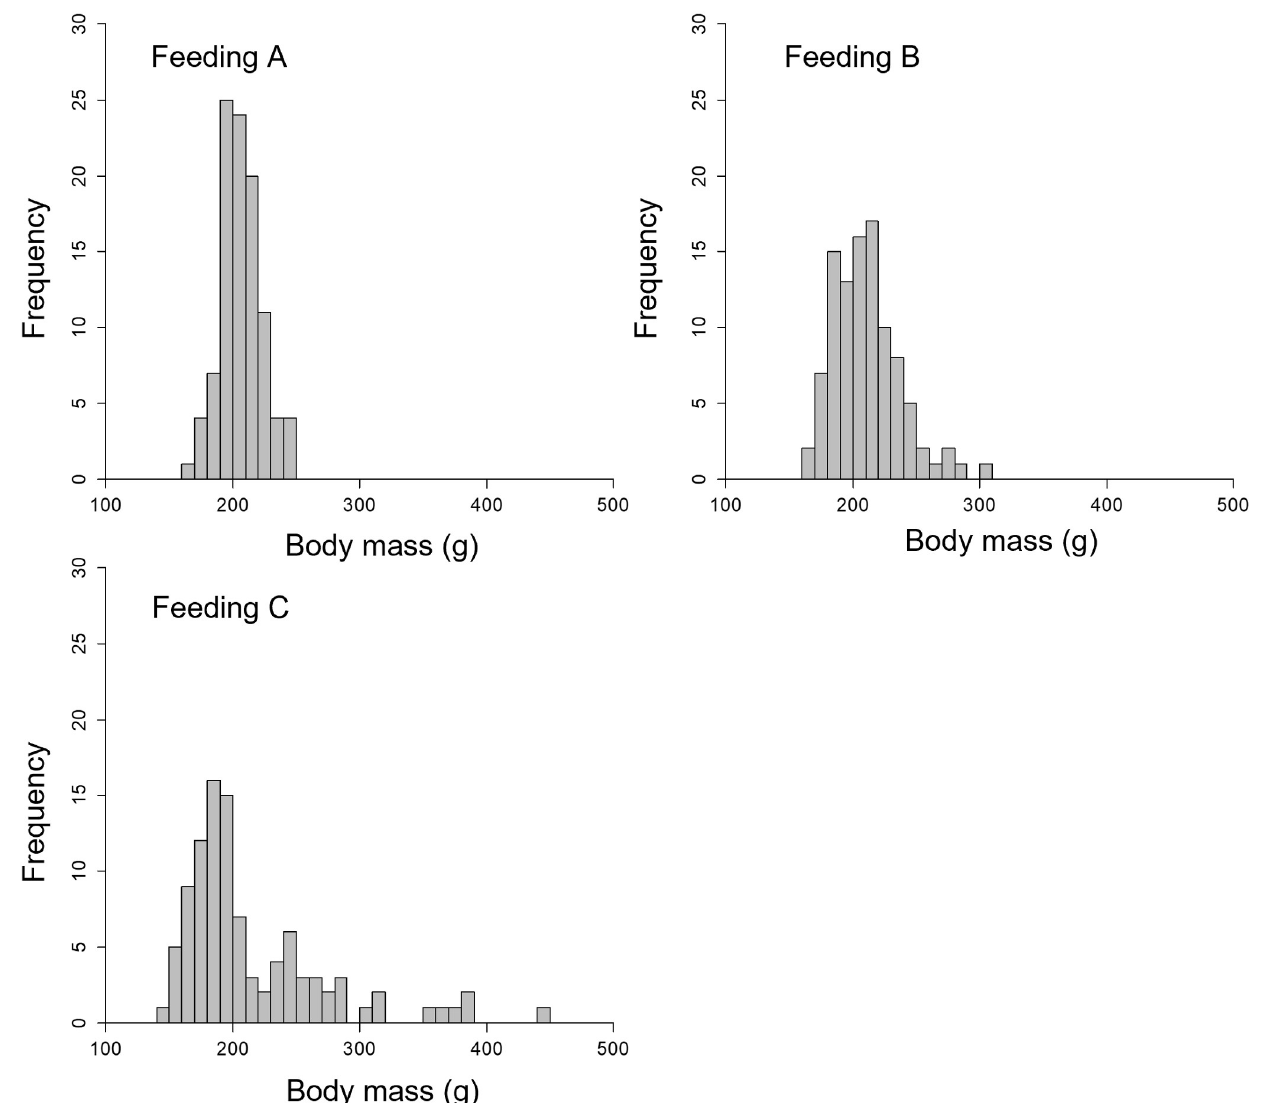
Fig 10. Histogram of the body mass of 100 individuals using the three feeding methods on day 90.